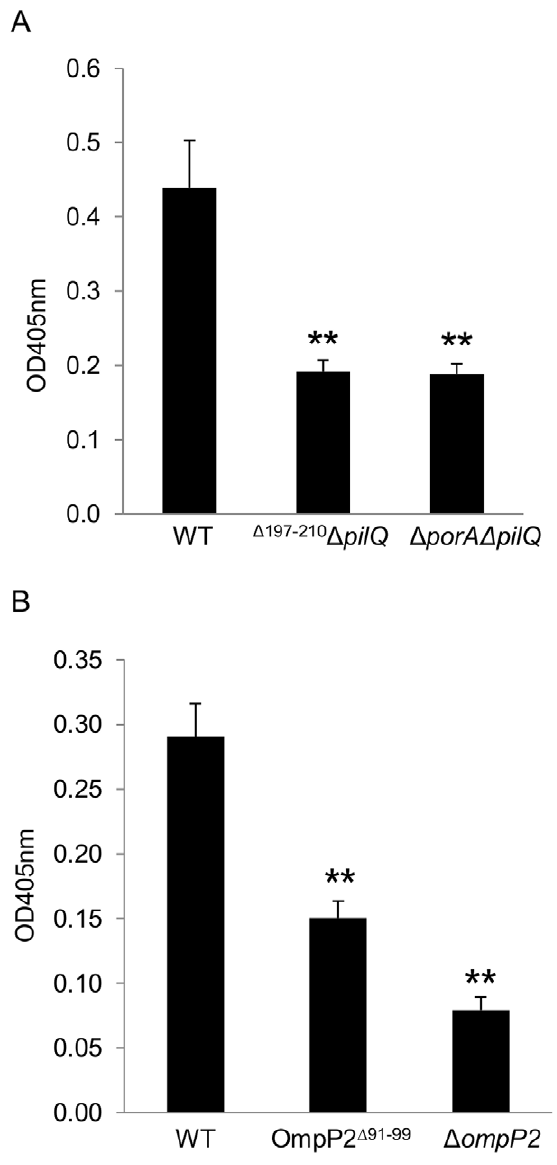
Figure 7. Deletion of PorA loop 4 or OmpP2 loop 2 significantly reduces bacterial LamR-binding. Binding of (A) N. meningitidis MC58, MC58PorA D 197–210 D pilQ and MC58 D porA D pilQ or (B) H. influenzae Rd KW20, RdOmpP2 D 91–99 or Rd D ompP2 to LamR. Specific binding of digoxigenin-labeled bacteria to LamR-coated ELISA plates was deter- mined by subtracting the absorbance in BSA-coated wells from that in LamR-coated wells. Data shown in each panel are means from three independent experiments; in each experiment each sample was tested in triplicate. ** p , 0.01 compared to wild-type. Error bars indicate SEM.